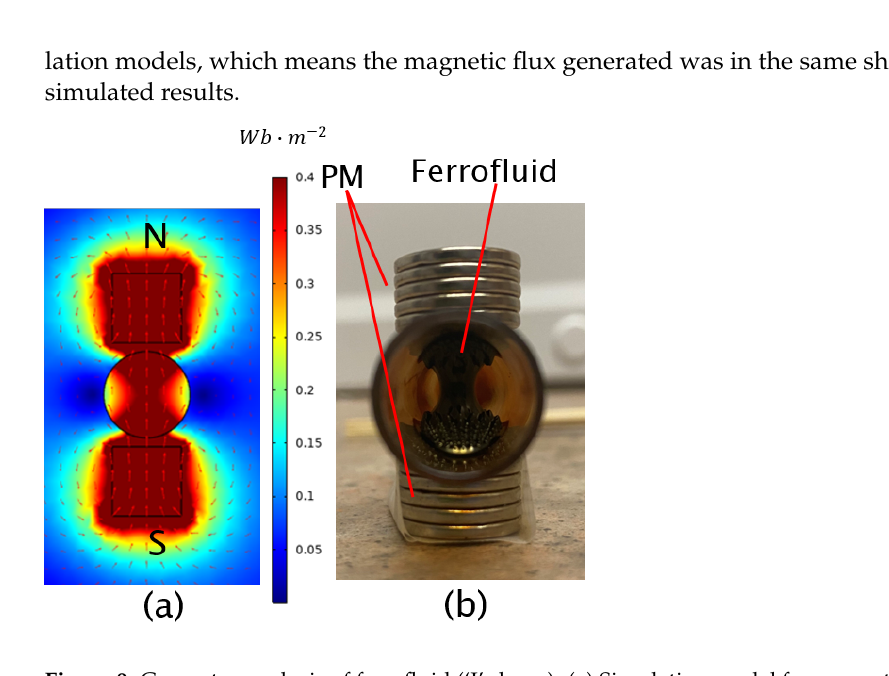
Figure 9. Geometry analysis of ferrofluid (‘I’ shape). ( a ) Simulation model for magnetic flux. ( b ) Ex- perimental shape of ferrofluid.